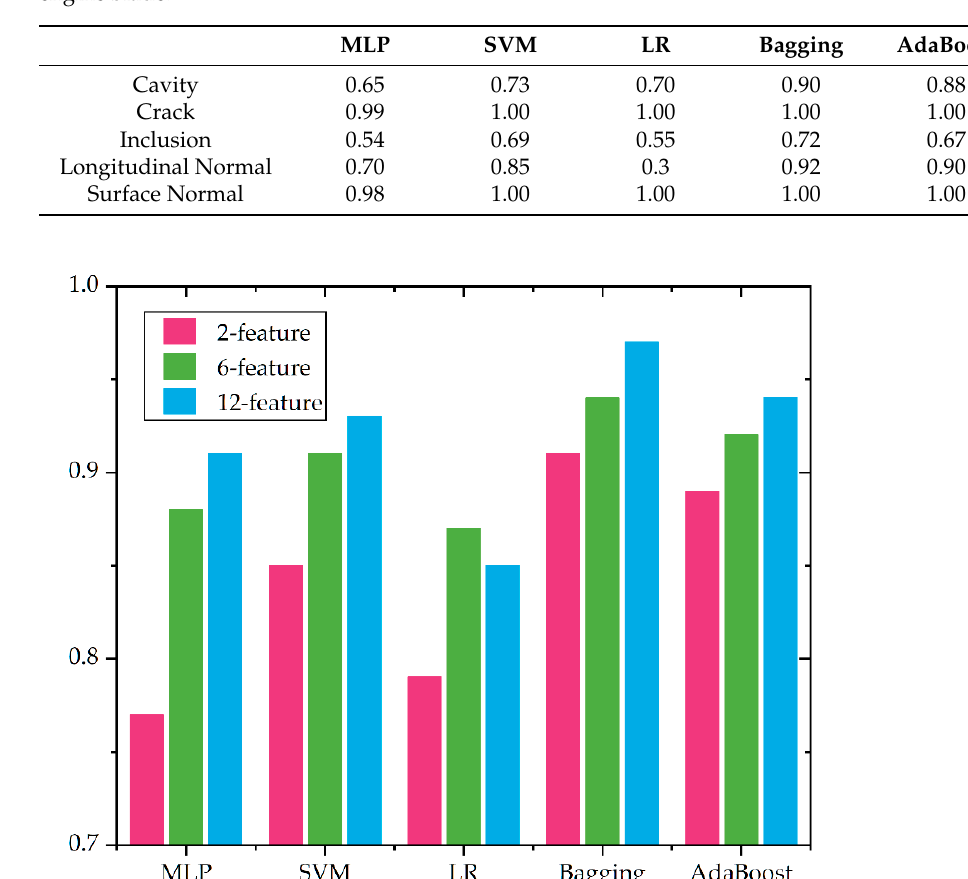
Table 2. The accuracy of different algorithm on the identification of different defect types of aero ‐ engine blade.